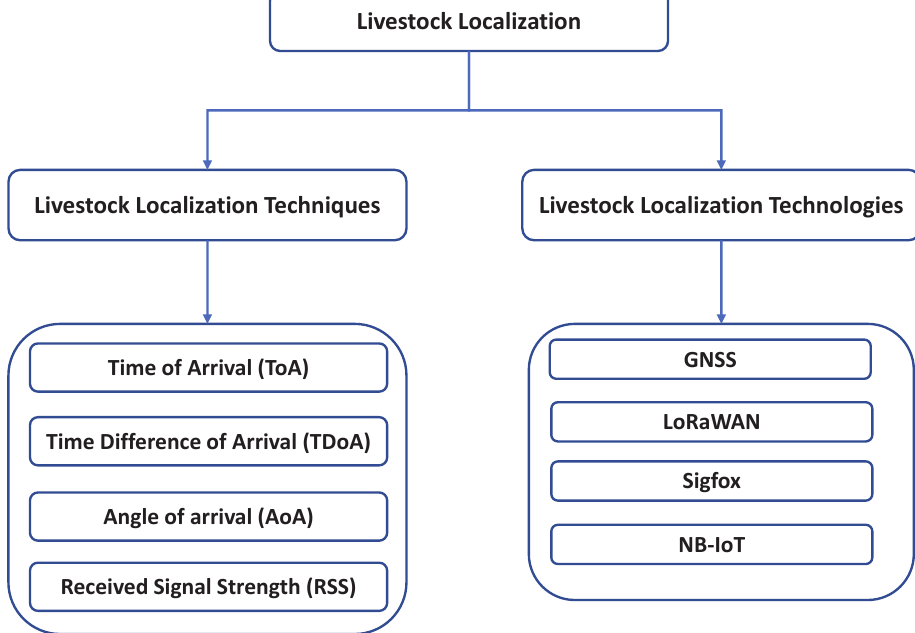
Figure 1. Livestock localization